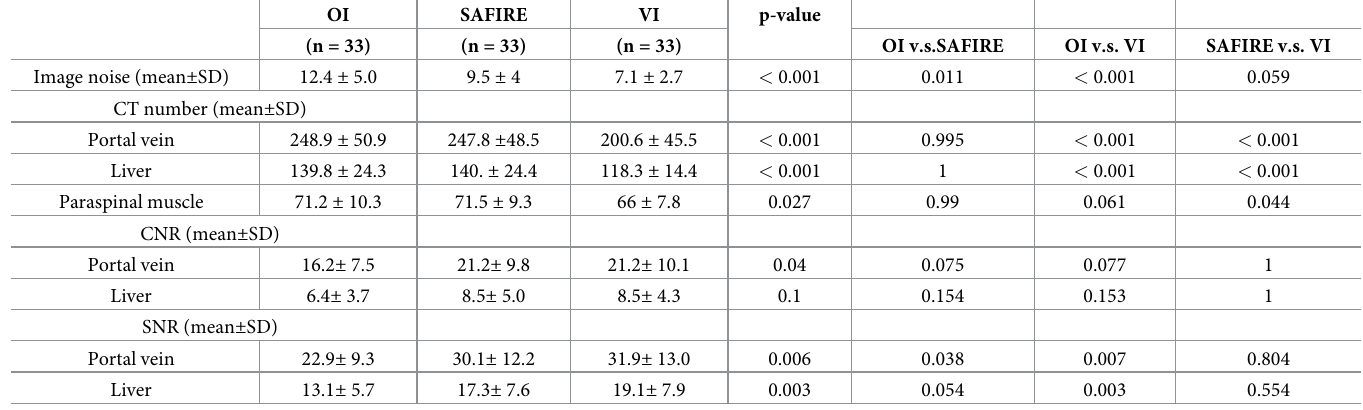
Table 3. Quantitative image analysis test data.